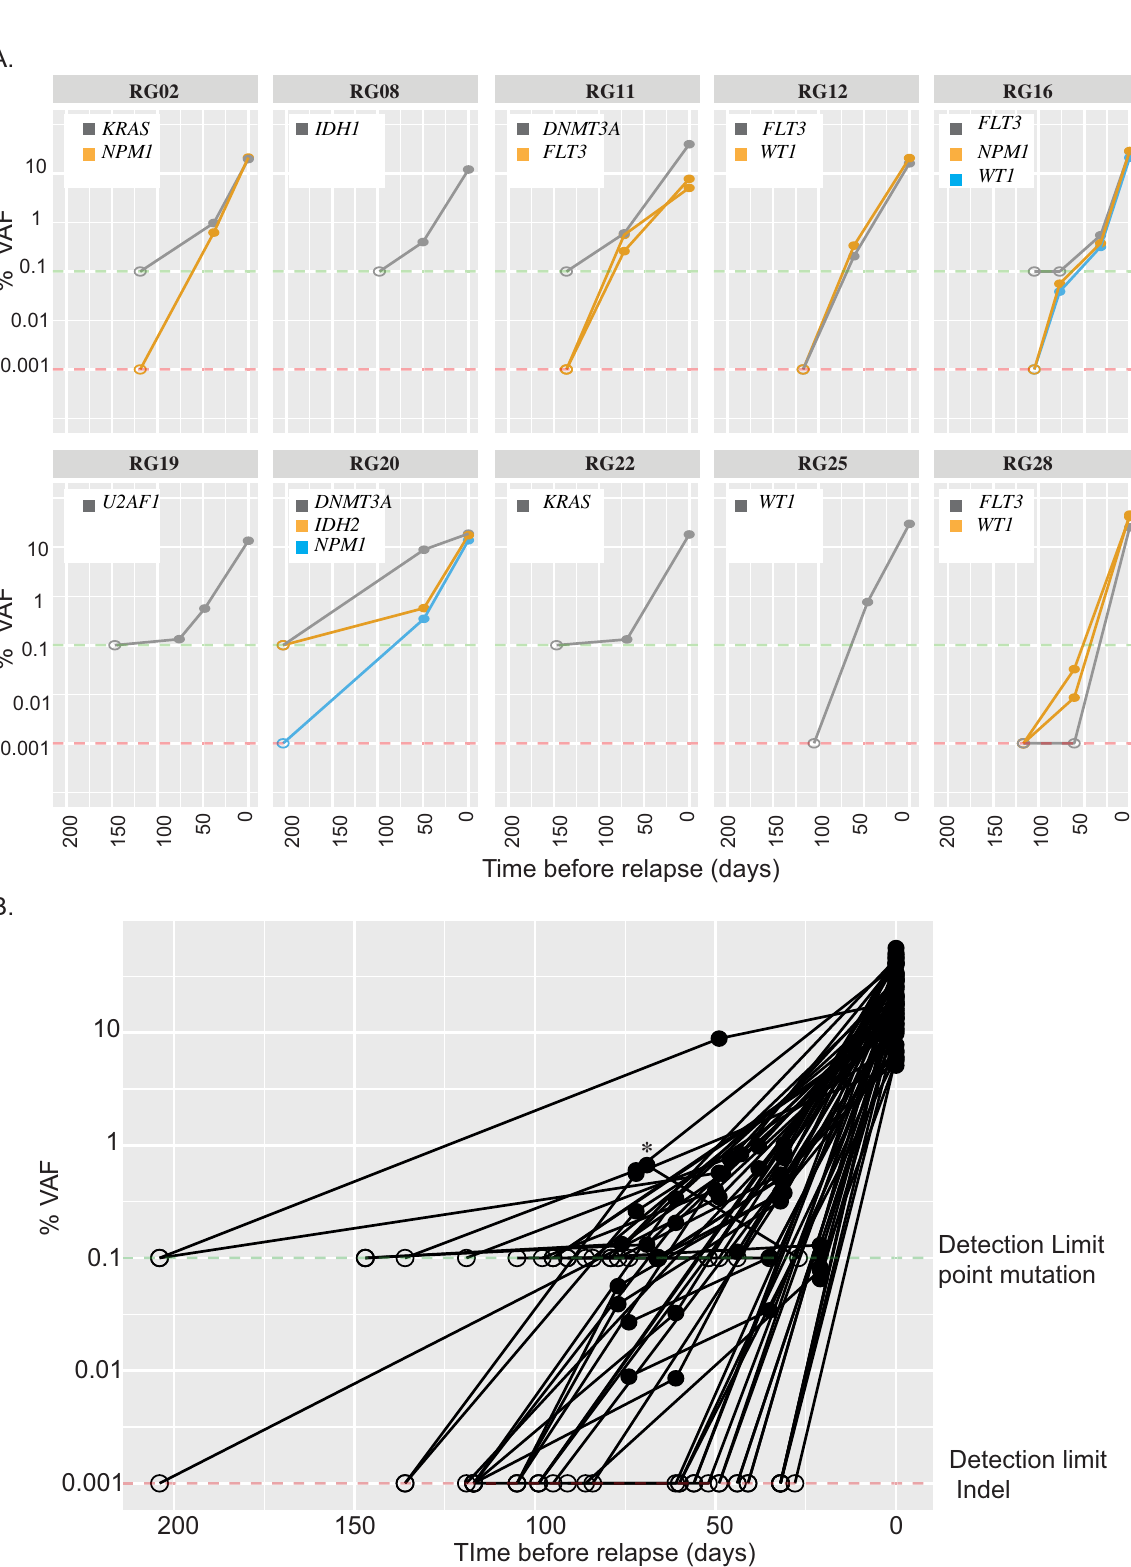
Fig 5. All trackable mutations can be used as MRD markers in post-transplant setting. ( A) Shown are 10 MRD positive patients where additional fully-engrafted samples (via STR PCR/histology) were available in the > 100 day time-period prior to relapse. The VAF of